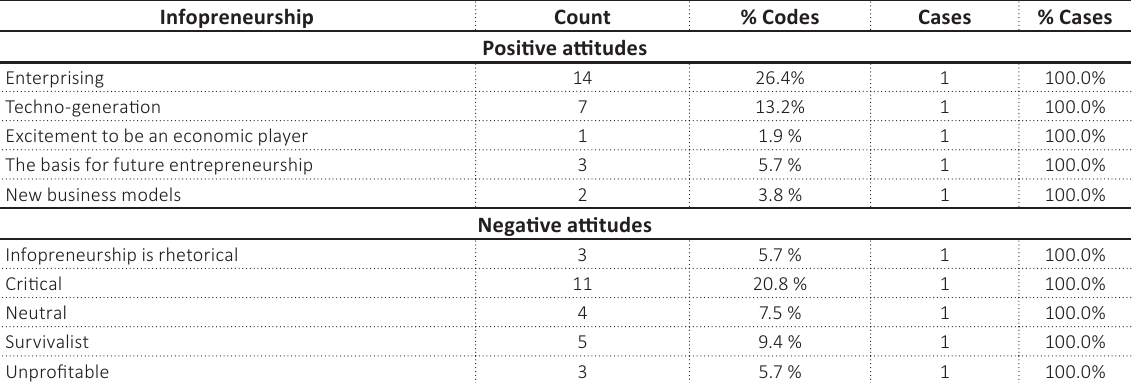
Positive attitude